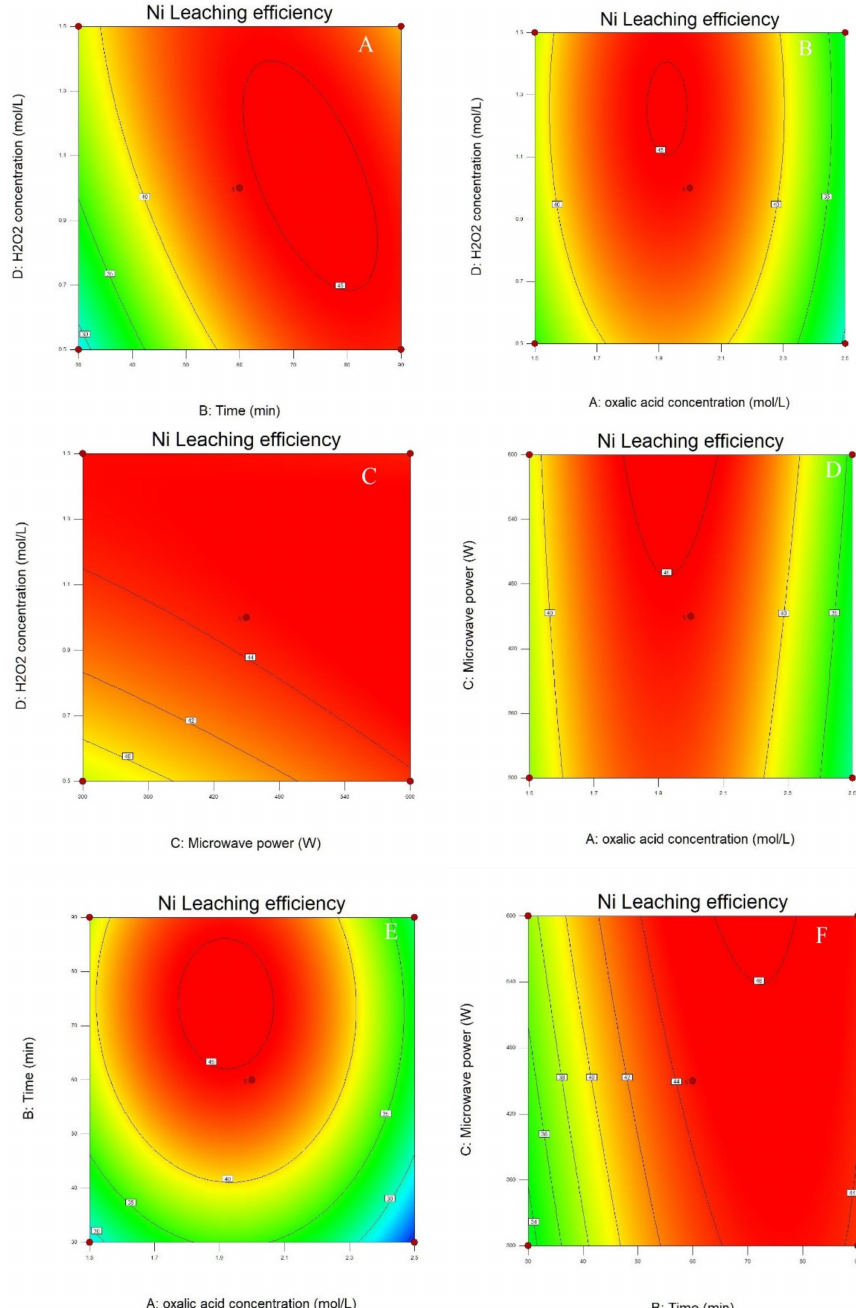
Figure 5. Contour plots of the effects of various parameters on Ni extraction: ( A ) Relationship of H 2 O 2 concentration and leaching time; ( B ) Relationship of H 2 O 2 concentration and C 2 H 2 O 4 concentration; ( C ) Relationship of H 2 O 2 concentration and microwave power; ( D ) Relationship of C 2 H 2 O 4 concentration and microwave power; ( E ) Relationship of C 2 H 2 O 4 concentration and leaching time; ( F ) Relationship of leaching time and microwave